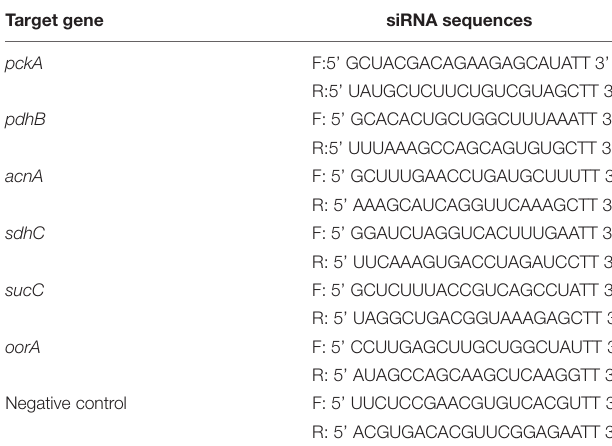
TABLE 1 | siRNA sequences.